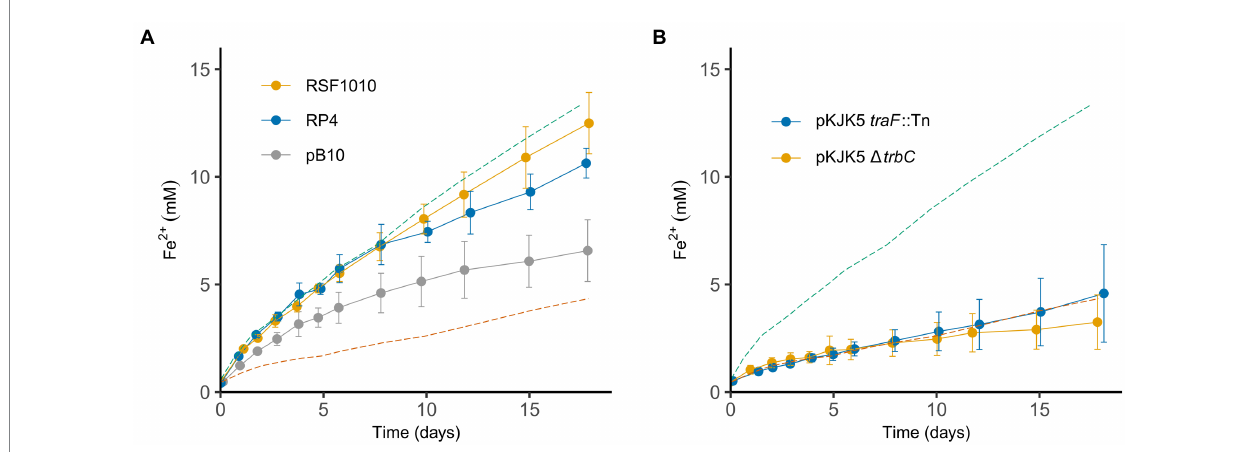
FIGURE 3 Inhibition of iron reduction in G. sulfurreducens is a general feature of conjugative plasmids, but does not depend on the conjugative pilus. Fe 2 O 3 reduction by G. sulfurreducens with three different plasmids [ (A) , n = 6]; pB10 (conjugative), RP4 (conjugative) and RSF1010 (mobilzable), and with two non-conjugative versions of pKJK5 [ (B) , n = 6]. Stippled lines show Fe 2 O 3 reduction of G. sulfurreducens WT (green) and G. sulfurreducens WT + pKJK5 (orange) from Figure 1A to ease comparison. Error bars show